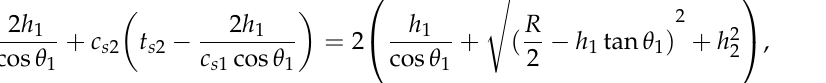
The thickness measurement of a bi-layer material is then achieved. In the same way, it is possible to determine each layer’s thickness layer by layer in a multi-layered structure with n layers by: